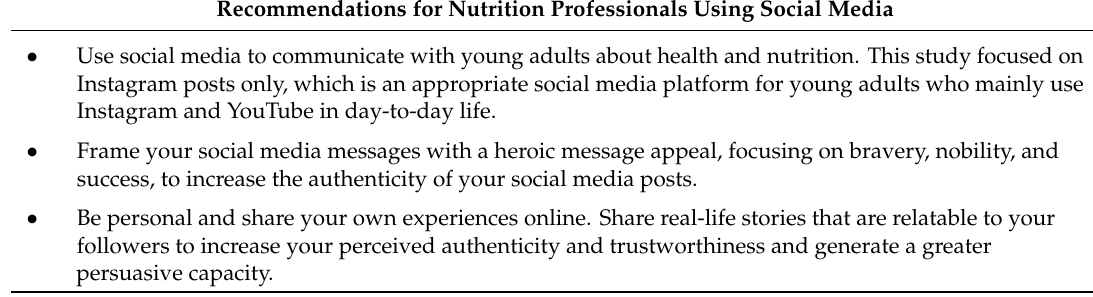
Table 6. Recommendations for nutrition professionals utilising social media